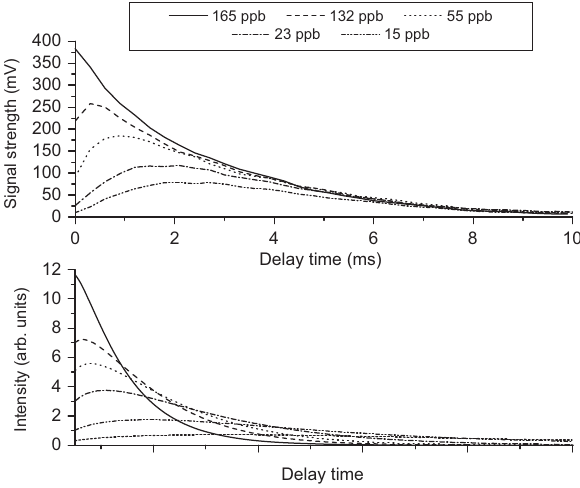
Figure 4 Comparison of measured (upper graph) and calculated (lower graph) signal intensities for a dimer signal (measurements shown for ethyl methyl ketone).